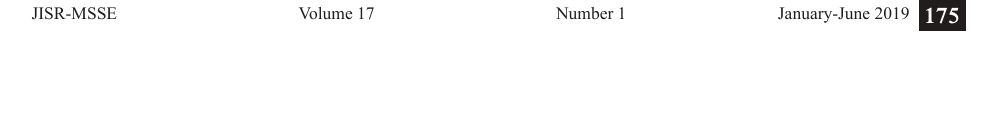
Panel B: Mean Size & Style Indices Returns and p-values